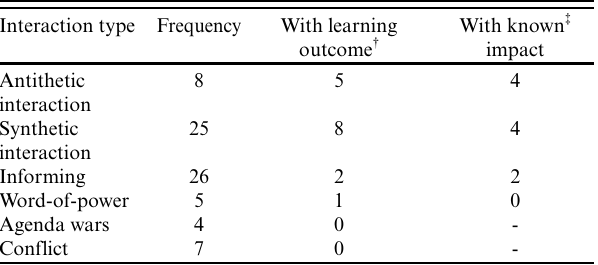
Table 2 . Frequencies of interaction types, learning outcomes,